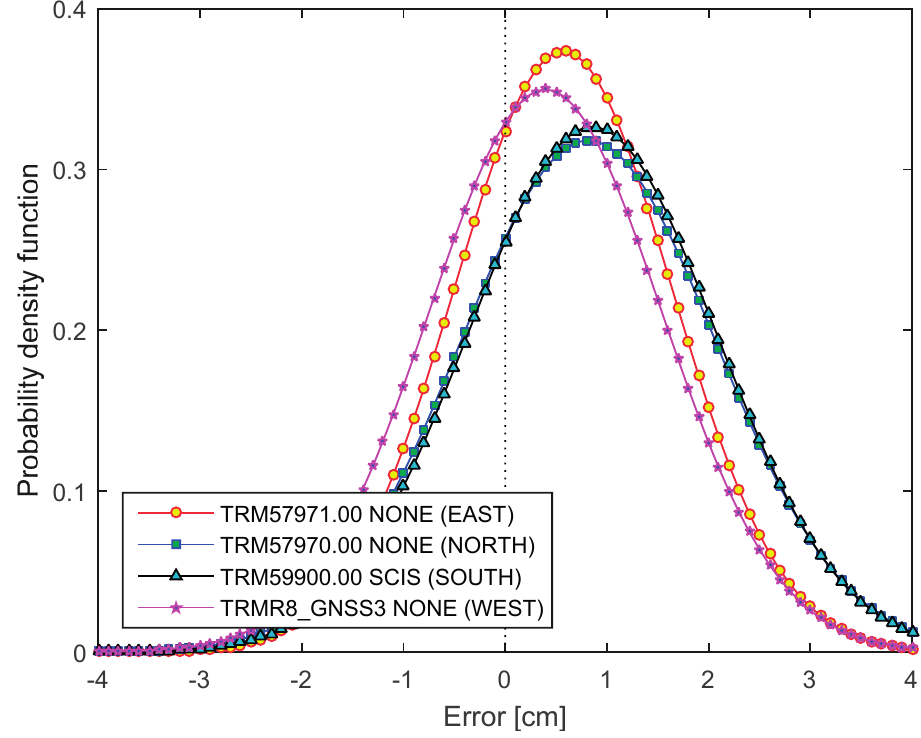
Figure 7. Probability density function (pdf) of RT solutions by antenna types for Phase 1.